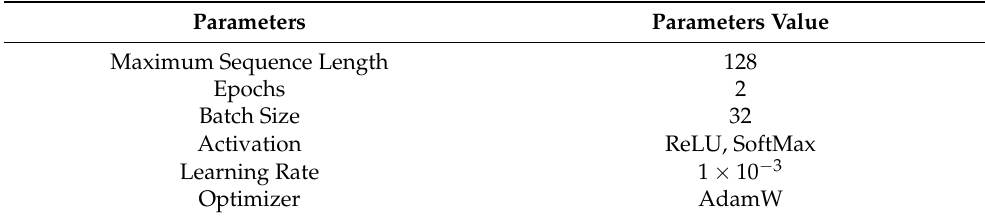
Table 2. Initial hyperparameters adapted for